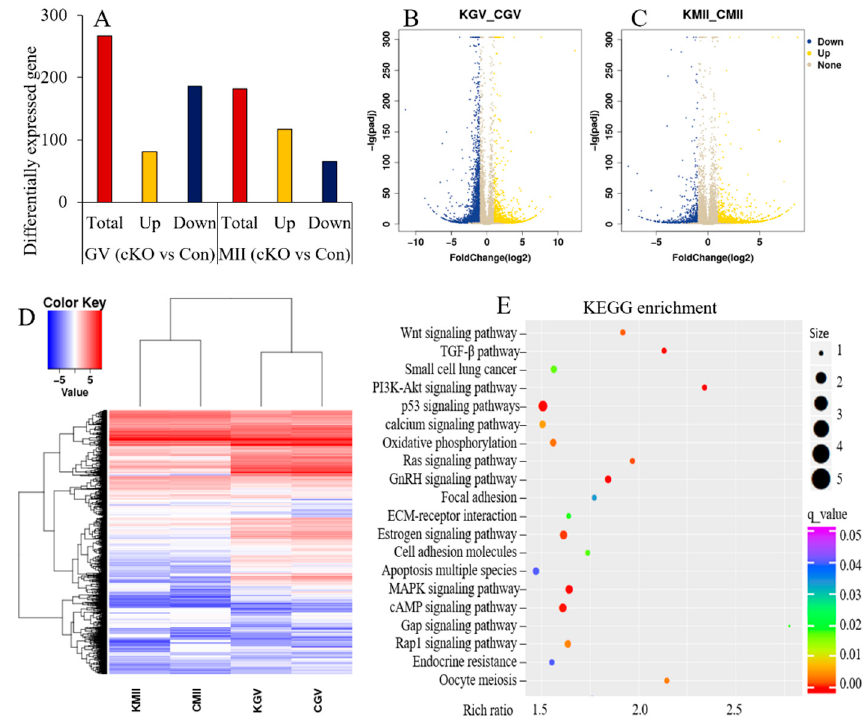
Figure 8. Kdm2a knockout impacts on the genes expression and signaling pathways during oocytes meiotic maturation. ( A ) the total number of differentially expressed genes between Kdm2a cKO (cKO) and control (Con) group oocytes of GV- and MII-stage, including up-regulated and down-regulated genes. ( B ) Volcano plot for the differentially expressed genes in GV-stage oocytes between Kdm2a cKO and control group, and ( C ) Volcano plot for the differentially expressed genes in MII-stage oocytes between Kdm2a cKO and control group. ( D ) Hierarchical clustering based on transcriptomic difference among GV-stage and MII-stage oocytes collected from Kdm2a cKO and control mice. ( E ) KEGG enrichment analysis of the differentially expressed genes in Kdm2a cKO oocytes compared with the control group. KGV: GV-stage oocytes from Kdm2a cKO group; CGV: GV-stage oocytes from control group; KMII: MII-stage oocytes from Kdm2a cKO group; CMII: MII-stage oocytes from control group.